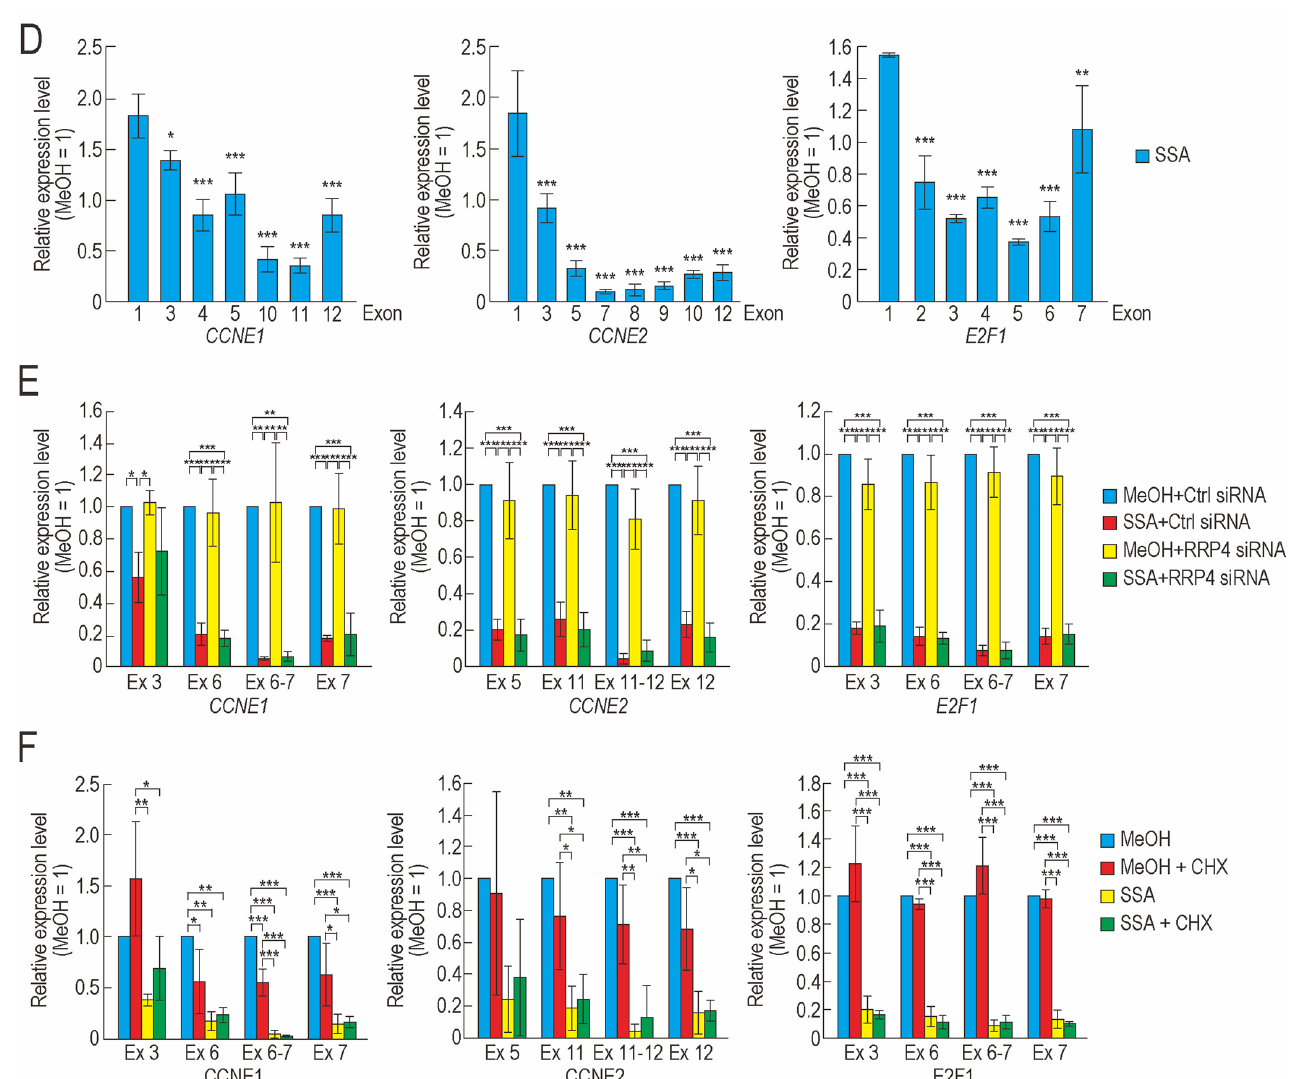
Figure 2. SSA inhibits transcription elongation of cell cycle regulator genes. ( A ) Schematics of CCNE1 promoter-GFP, CCNE2 promoter-GFP, and E2F1 promoter-GFP reporter genes. Boxes, dotted horizontal lines, solid horizontal lines, and arrowheads represent exons, introns, promoter regions, and transcription start sites, respectively. ( B ) Synchronized cells were released from the first thymidine block and transfected with reporter plasmids. Eight hours after release from the second thymidine block, the cells were treated with 10 ng/mL SSA or MeOH, and newly synthesized RNAs were labeled with EU between 4 and 5 h after SSA treatment. Labeled RNAs were then analyzed using qRT-PCR. ( C ) Eight hours after release from the second thymidine block, SSA treatment and nascent RNA labeling were performed as described in ( B ). Labeled RNAs were analyzed using qRT-PCR. ( D ) Reanalysis of our previous exon array data [27]. Each bar represents the relative expression level of exons. ( E ) Synchronized cells were released from the first thymidine block and transfected with RRP4 siRNA (RRP) or control siRNA (Ctrl). Eight hours after release from the second thymidine block, SSA treatment and nascent RNA labeling were performed as described in ( B ). Labeled RNAs were analyzed using qRT-PCR. ( F ) Eight hours after release from the double thymidine block, the cells were treated with 10 ng/mL SSA and 10 µ g/mL CHX, and nascent RNA labeling was performed as described in ( B ). Labeled RNAs were analyzed using qRT-PCR. Error bars indicate standard deviation (n = 3). Statistical significance was investigated using a two-tailed t -test ( B ), one-way ANOVA, and Tukey’s test ( C , E , F ) or one-way ANOVA and Dunnett’s test ( D ) (* p < 0.05; ** p < 0.01; *** p <